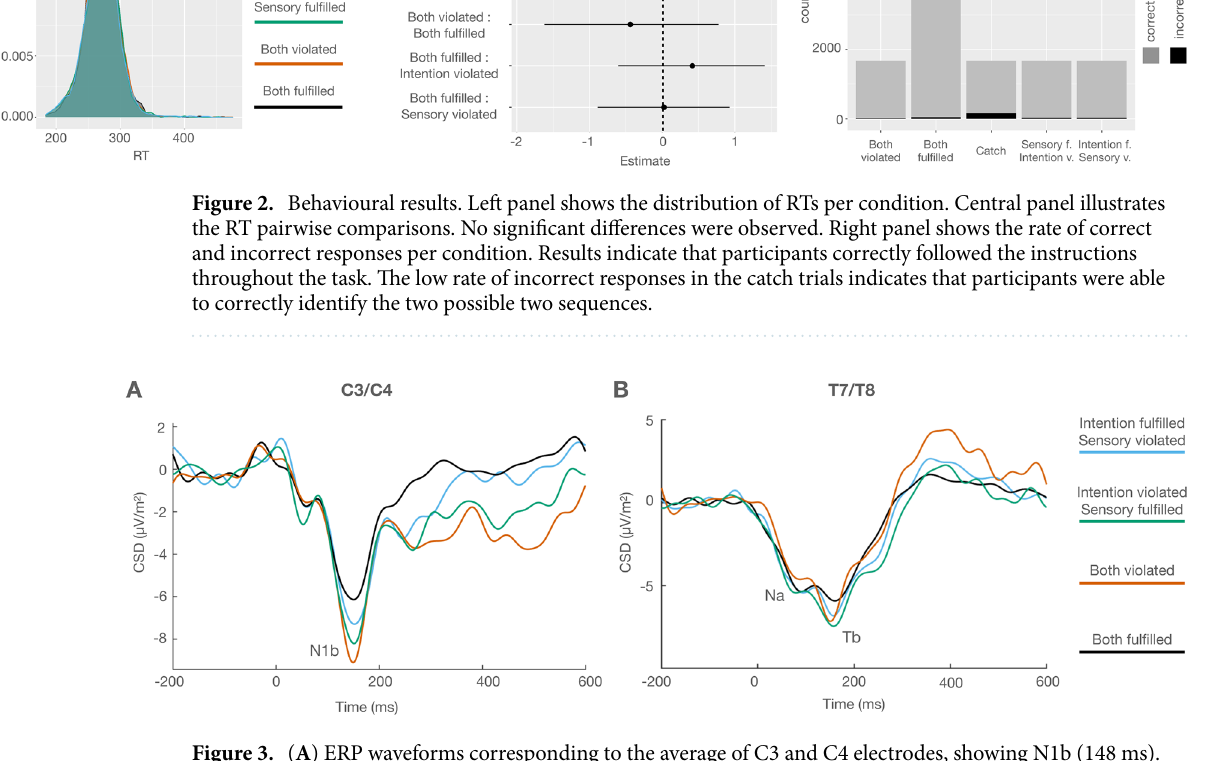
Figure 3. ( A ) ERP waveforms corresponding to the average of C3 and C4 electrodes, showing N1b (148 ms). ( B ) ERP waveforms corresponding to the average of T7 and T8 electrodes, depicting Na (80 ms) and Tb (158